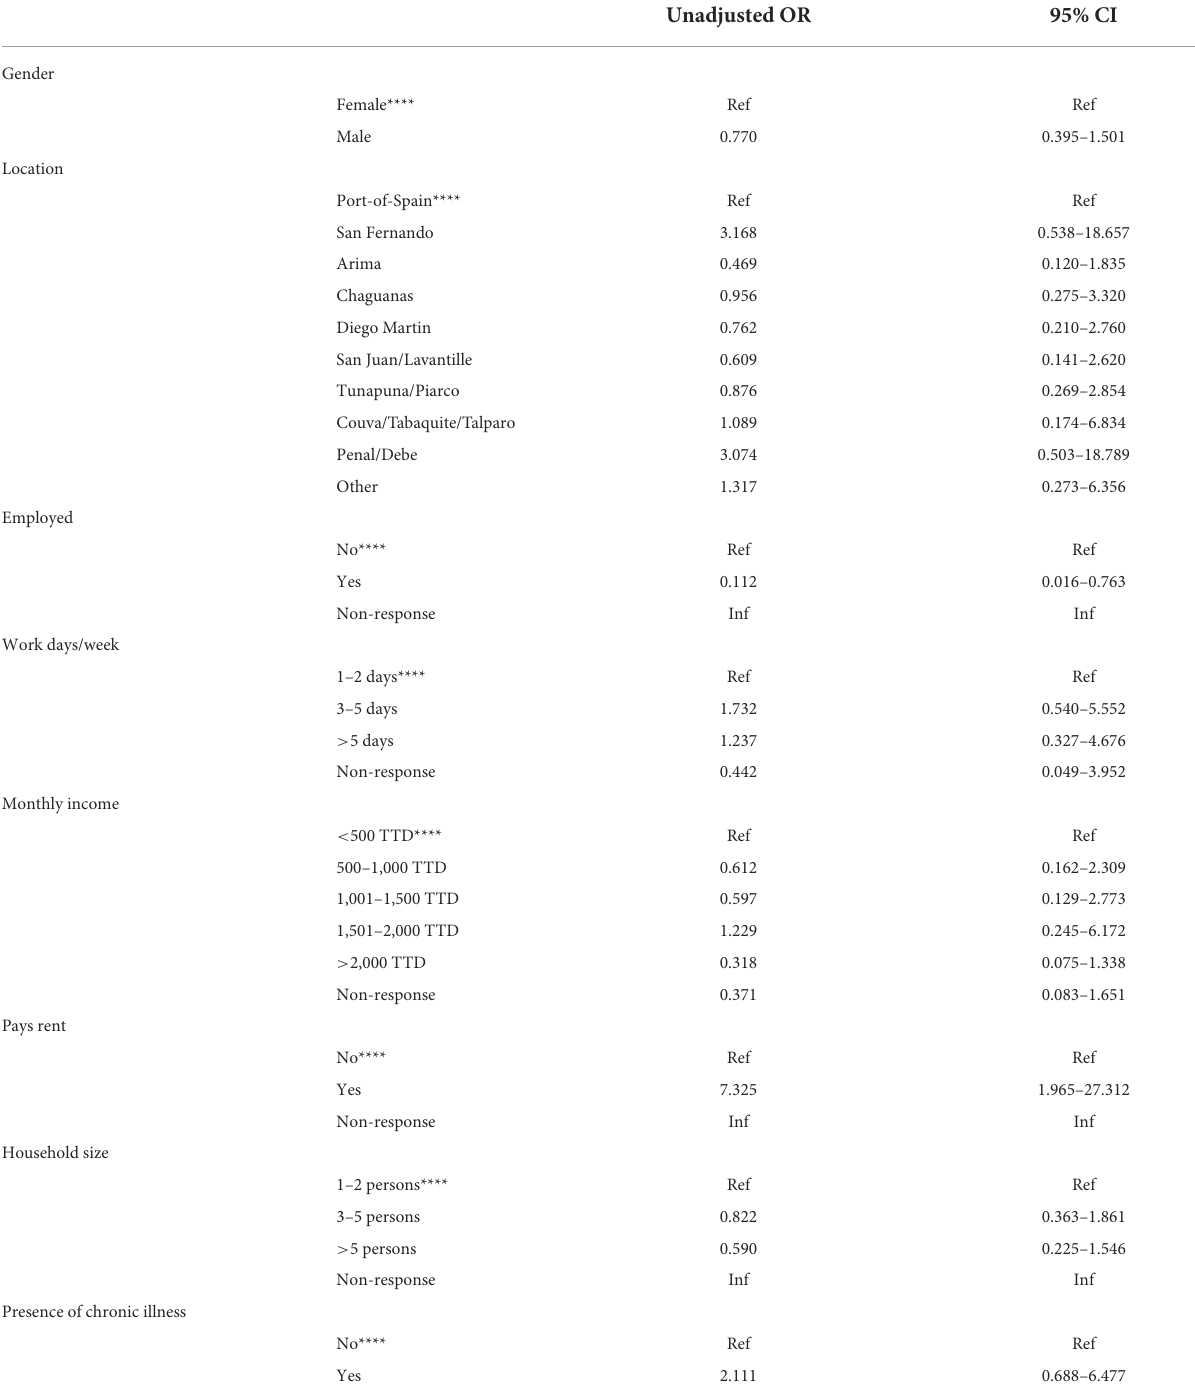
TABLE 5 Multivariate associations of sociodemographic characteristics with food insecurity in terms of adjusted odds ratios (OR) and 95% confidence intervals